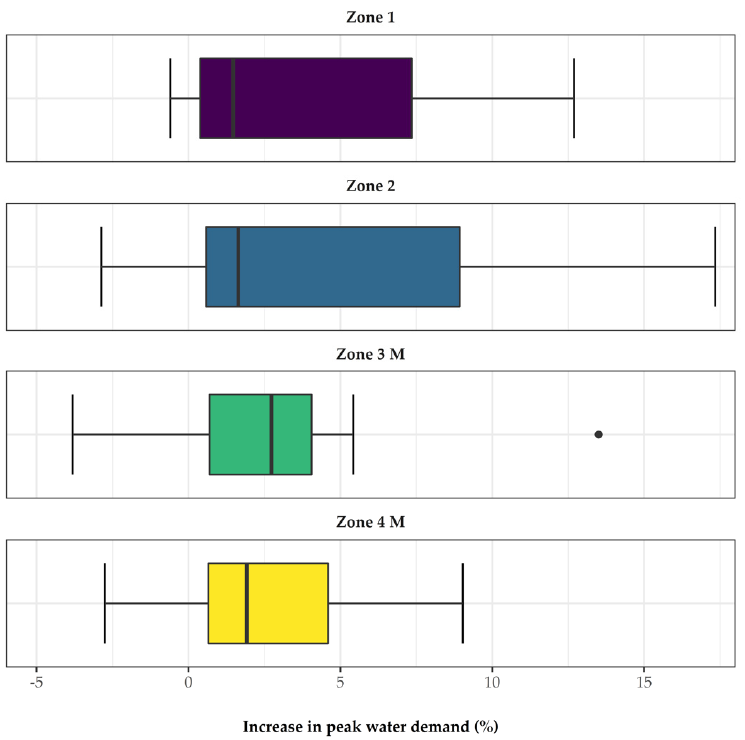
Figure 6. Increase in peak water demand. The percentage change of future peak water demand is shown in relation to the reference period. Water 2021 , 13 , x FOR PEER REVIEW Furthermore, the future peak water demand days were determined, these are shown in Figure 7. The left side shows the number of peak water demand days for the reference period 1980–2005 and the right side shows the number of peak water demand days for the period 2025–2050. While the average of all projections shows a slight increase of 1 peak water demand day, there were some projections that project a decrease. This was again due to the previously mentioned different changes of the climate projections.